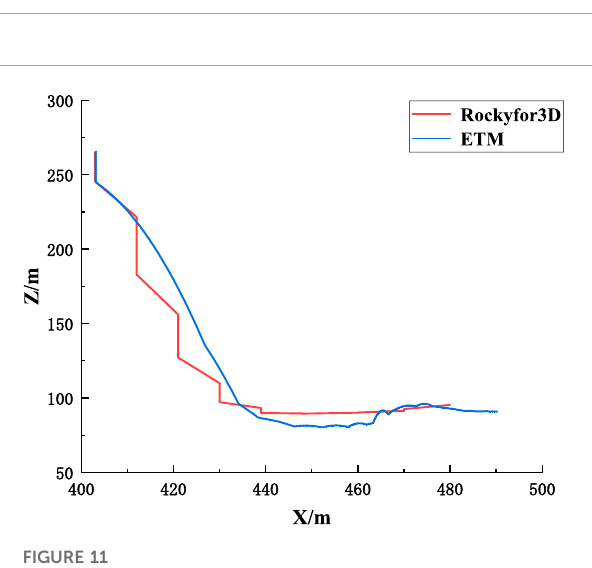
FIGURE 10 The hexahedral shape model of rockfall.